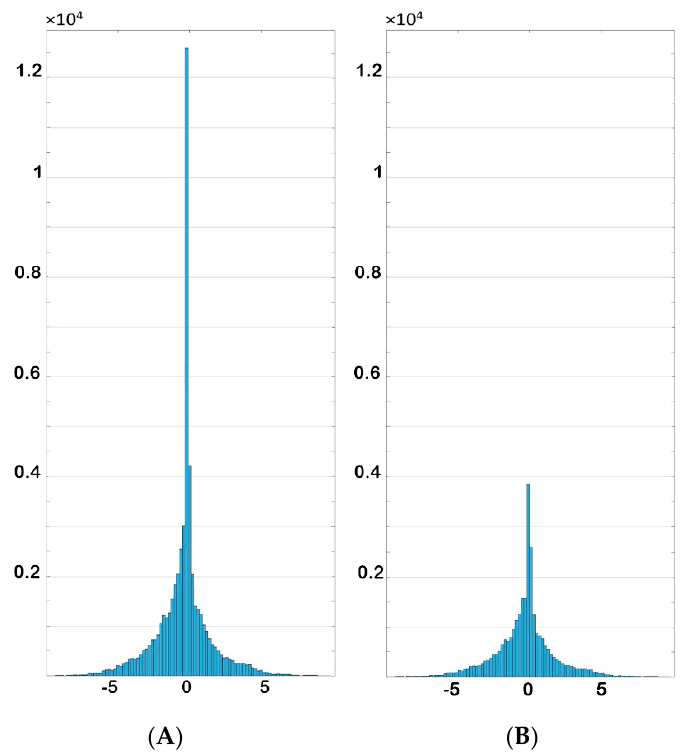
Figure 31. Histogram of x -direction-velocity ( A ) before and ( B ) after elimination.